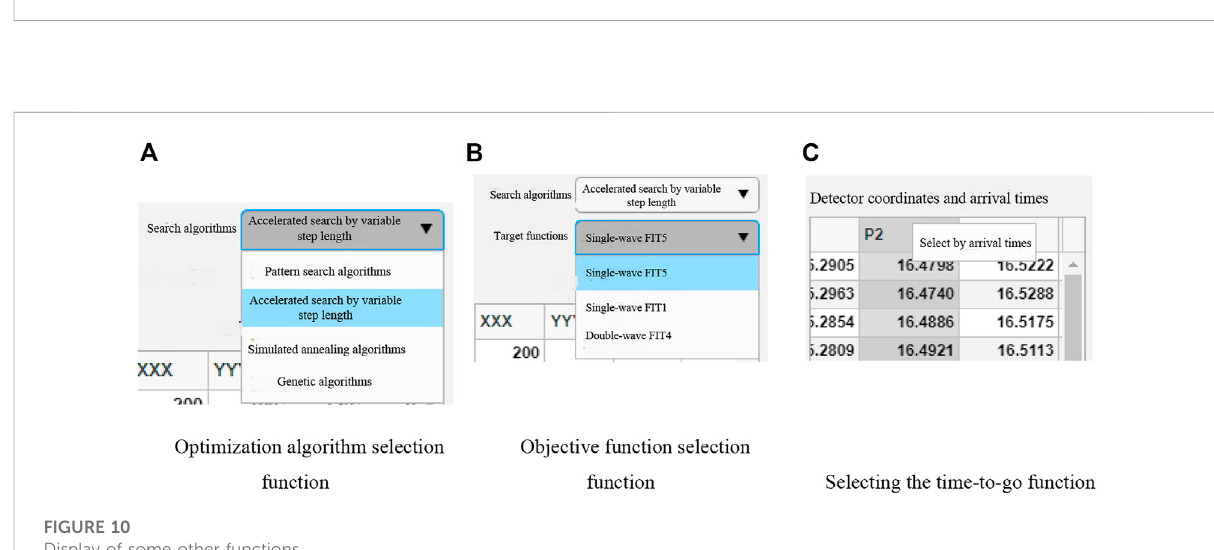
FIGURE 9 Basic function graphical user interface.